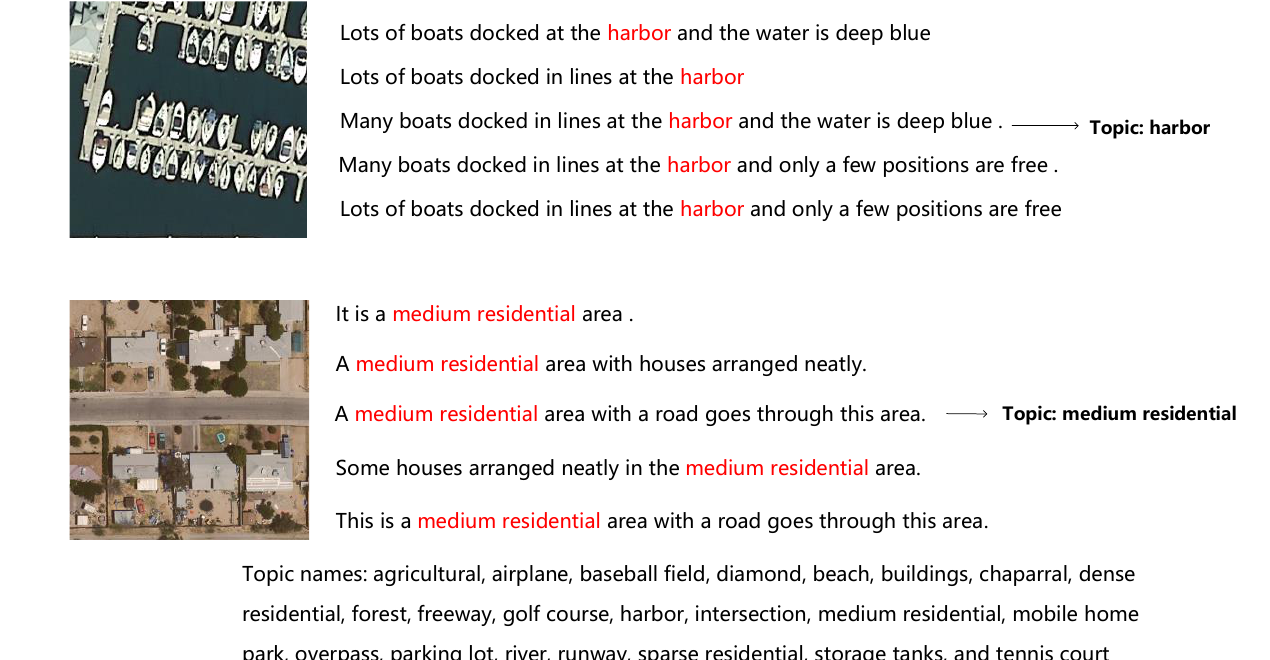
Figure 5. Two examples of extracting topics from data sets. The total topic names are also